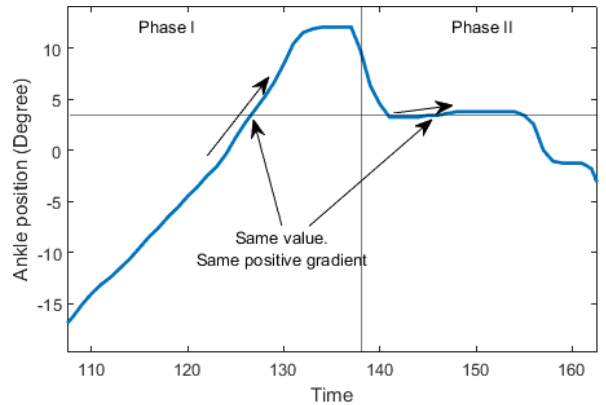
Figure 8: Comparison of ankle position during 1 step cycle in phase I and phase II